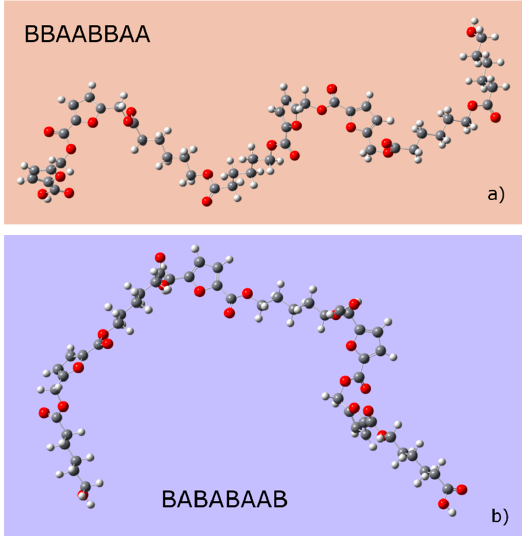
Figure 6. The optimized most stable structures of the linear copolymers containing four HMFA (A) and four ECL (B) monomeric units, based on the energy-stability, and ( a ) chemical reactivity ( b ). Heat formation values, HOMO, LUMO energy values, absolute hardness and chemical potential are presented in the Supplementary material, Table